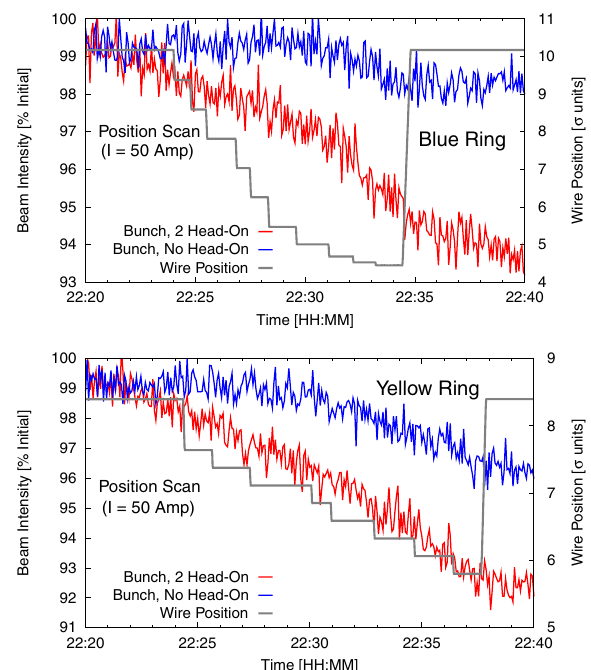
FIG. 18. Orbits right of IP6 for the Blue and the Yellow ring with the LR interaction setup near the DX magnet at approxi- mately 3 : 1 (cid:1)